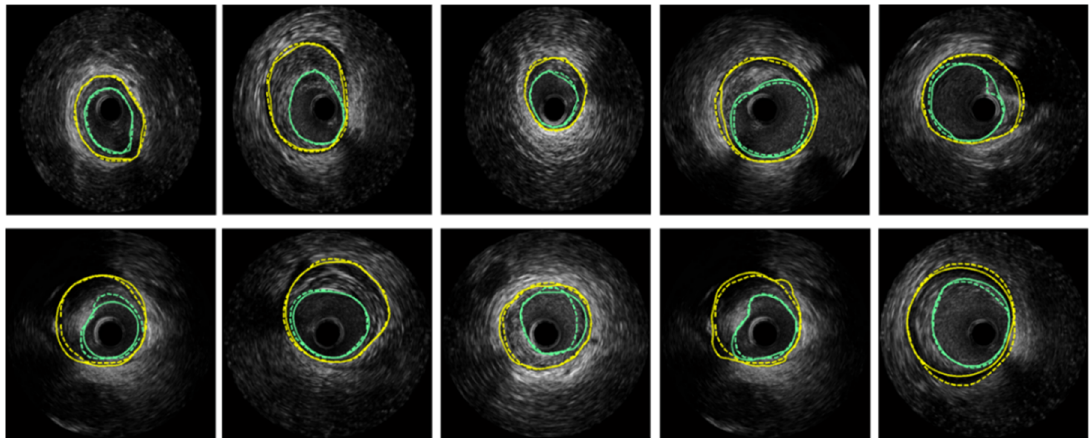
Figure 9. Segmentation examples of IVUS images; yellow and green contours denote the MA and lumen borders respectively (dotted lines denote detected borders by manual segmentation and full lines denote detected contours by proposed segmentation method, respectively). Table 1. Mean and standard deviations (Std) of the Dice similarity and Hausdorff distance between the lumen/MA (media ‐ adventitia) border obtained by our method and manual delineation.